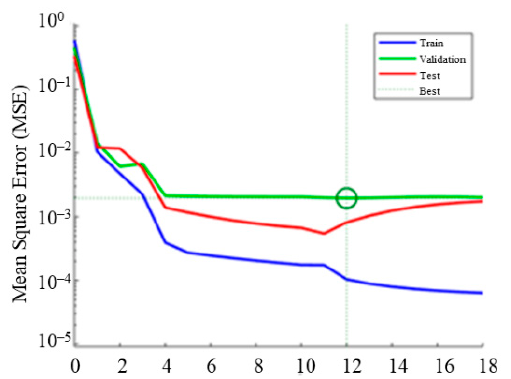
Figure 13. Network error curve obtained from the performance test with the least MSE.